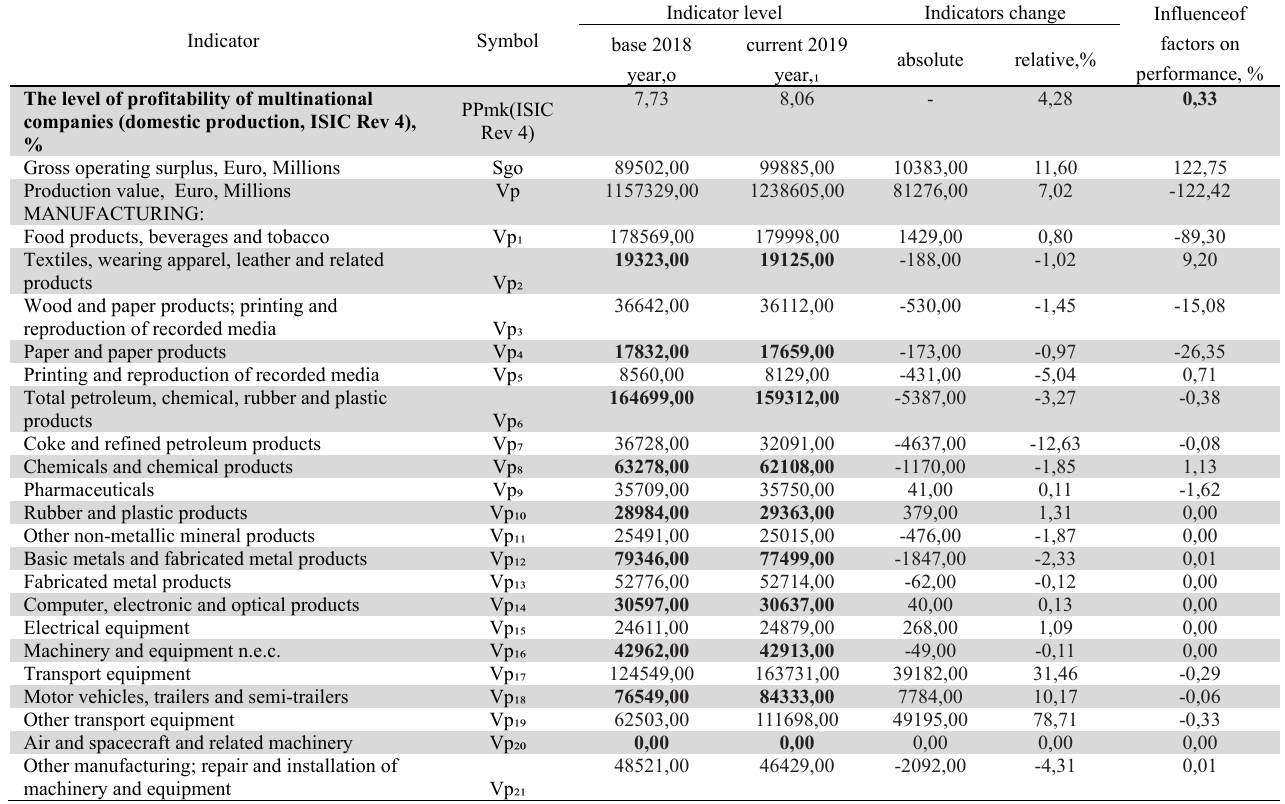
France (Dataset: Inward activity of multinationals by industrial sector - ISIC Rev 4) Indicator Symbol